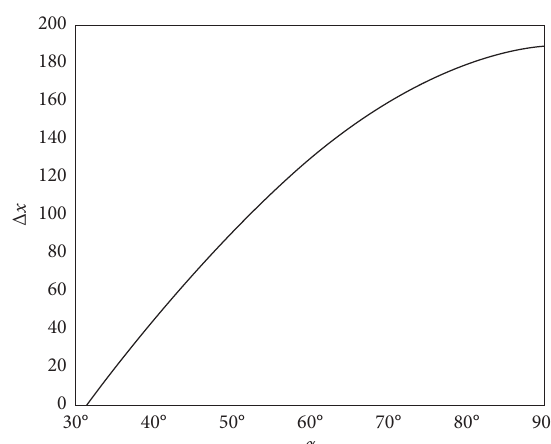
Figure 7: The displacement ∆ x of the compaction rod moves with α